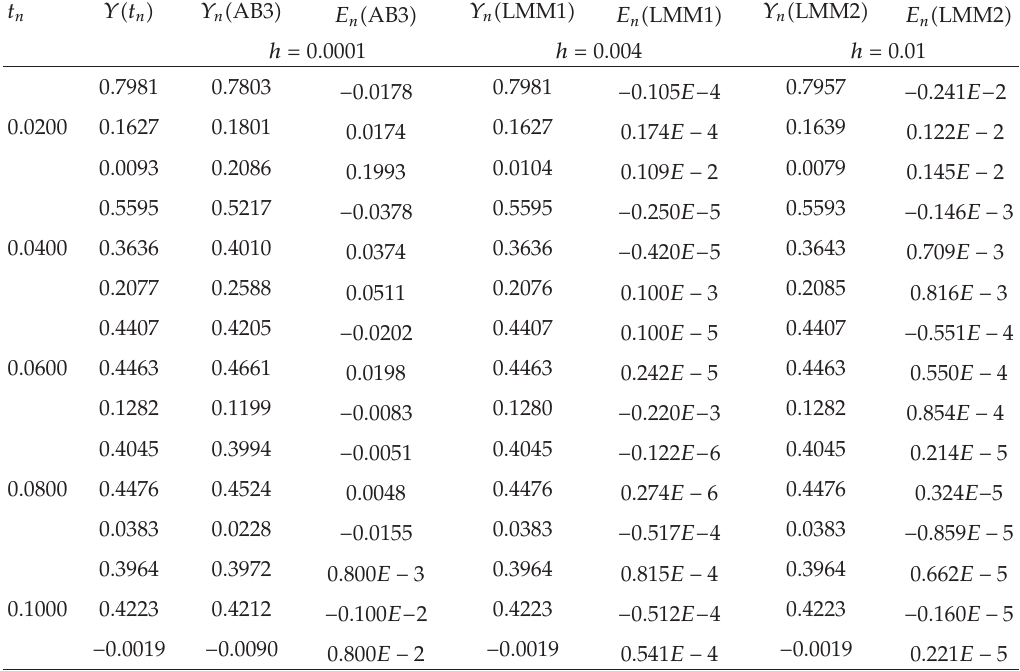
Table 3: Numerical solutions and errors of AB3, LMM1 and LMM2 for (cid:3) 5.1 (cid:4)